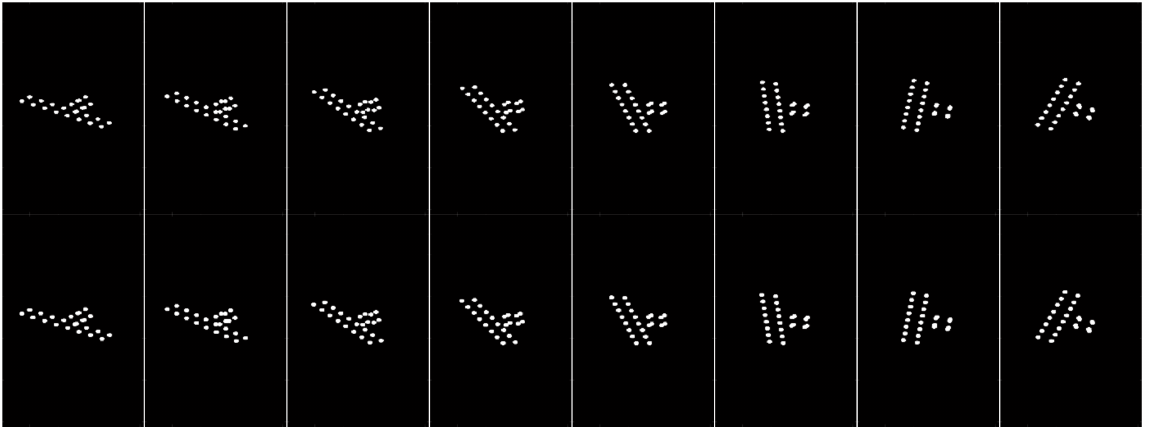
Figure 7. Comparisons between the ISAR image sequence and the projection image sequence of the simulated point model. The first row is part of the simulated ISAR image sequence and the second row is the corresponding result of the projection image